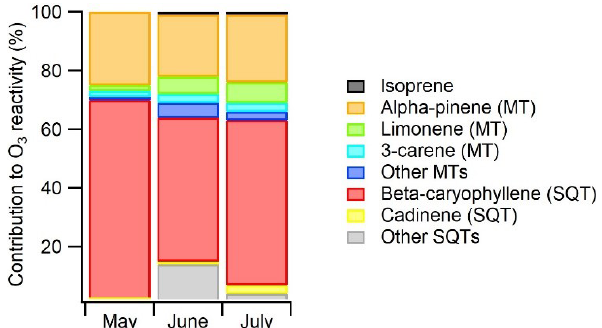
Figure 11. Contributions of various BVOCs to the ozone reactiv- ity during the ambient air measurements at Lompolojänkkä fen in 2018. The reaction rate coefficients used are listed as Table S4. gional